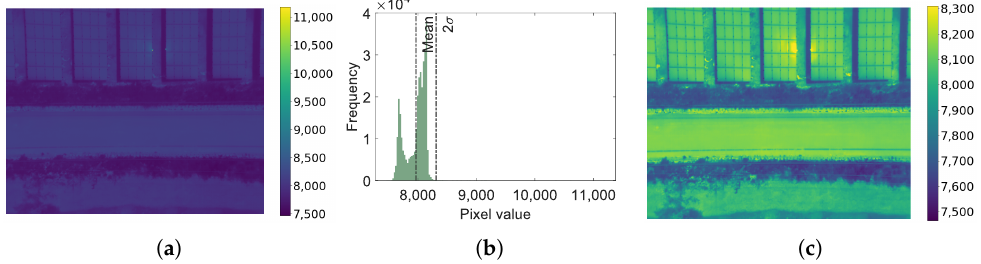
Figure 3. Image correction to reduce the effect of hot spots or sun reflection: ( a ) the original image; ( b ) the histogram with the probability distribution function and the values of the mean and twice the standard deviation; ( c ) the corrected